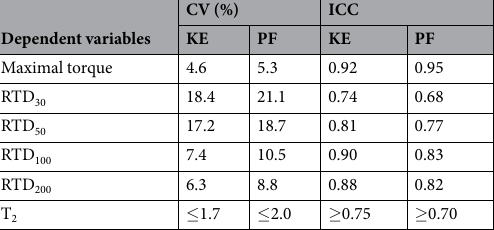
Table 1. The coefficient of variations (CVs) and intraclass correlation coefficients (ICCs) of the variables in between-days measurements (n = 10). KE: knee extensors, PF: plantar flexors, RTD 30, 50, 100, 200 : rate of torque 21